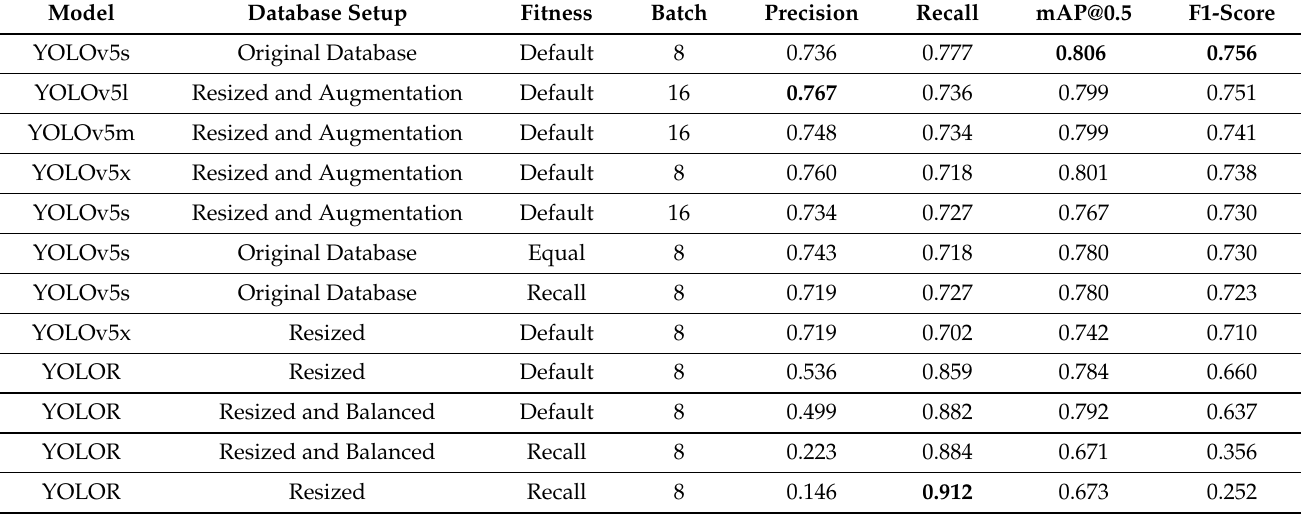
Table 3. Results of the object detection and